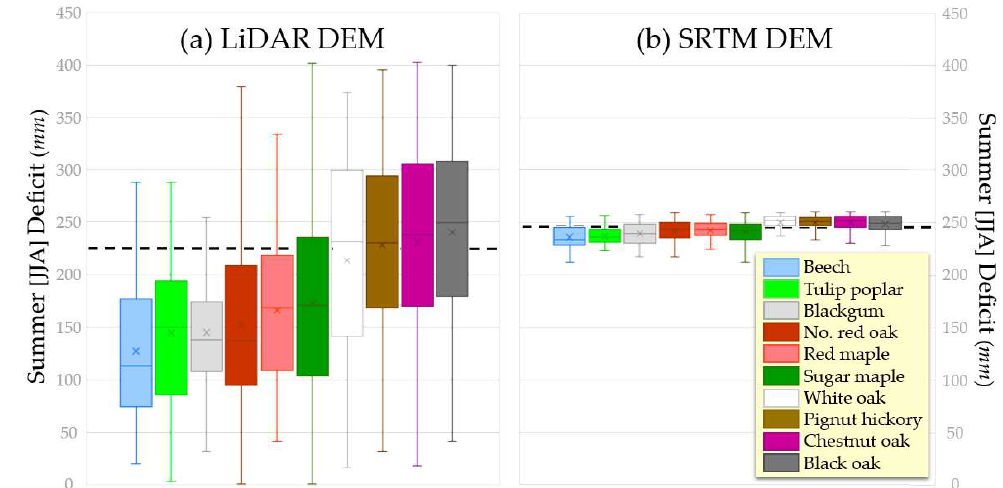
Figure 3. Box and whisker plots illustrating distribution of trees ≥ 30 cm DBH at Lilly–Dickey Woods with respect to summer 2012 water deficit, computed using ( a ) LiDAR-derived DEM, and ( b ) SRTM DEM. Dashed line represents average deficit value for the grid (Figure 2c,e). The top and bottom of each box represents the upper and lower quartiles, X represents the mean, and the horizontal line the